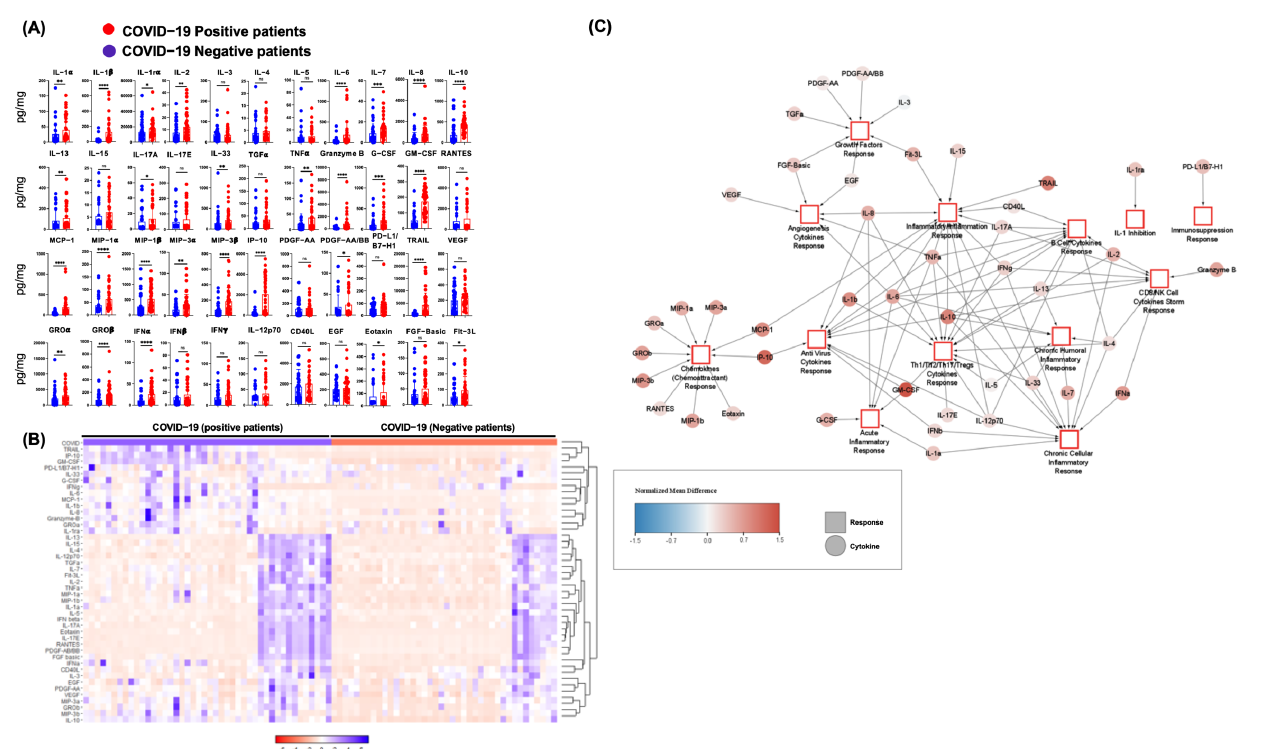
Figure 2. SARS-CoV-2 infection in humans is associated with increased cytokine/chemokine storms in the nasopharyngeal microenvironment. ( A ) A cytokine storm in the nasal swabs of RT-PCR COVID-19-positive (N = 44) and -negative (N = 40) patients was measured by a bead-based multiplex assay and analysed by FLEXMAP 3D. ( B ) A heatmap of cytokines between COVID-19-positive and -negative patients. Mean difference for each cytokine was calculated after z-score normalization and was used as a basis for hierarchical clustering analysis. ( C ) Cytoscape network displays cytokine storm responses in COVID-19-positive and -negative patients, represented as hubs (squares). Each dot represents an individual. * denotes p ≤ 0.05, ** denotes p ≤ 0.01, *** denotes p ≤ 0.001, **** denotes p ≤